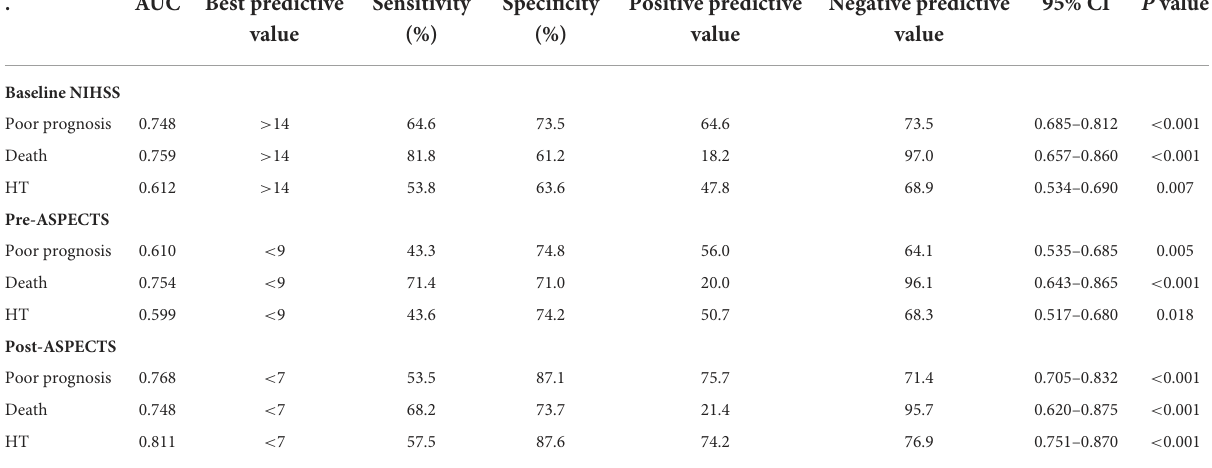
TABLE 4 ROC curve for 90-day prognosis, death, and HT.